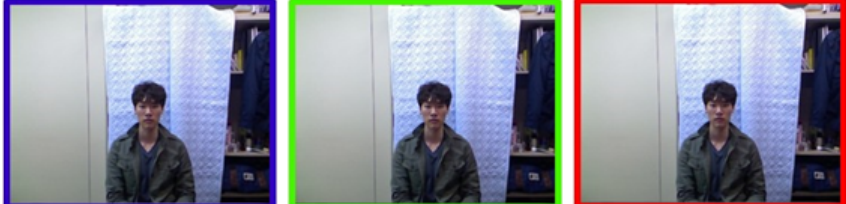
Figure 16. Three signals for the visual feedback: blue, gesture begin/end; green, success of recognizing a gesture; red, fail to recognize a